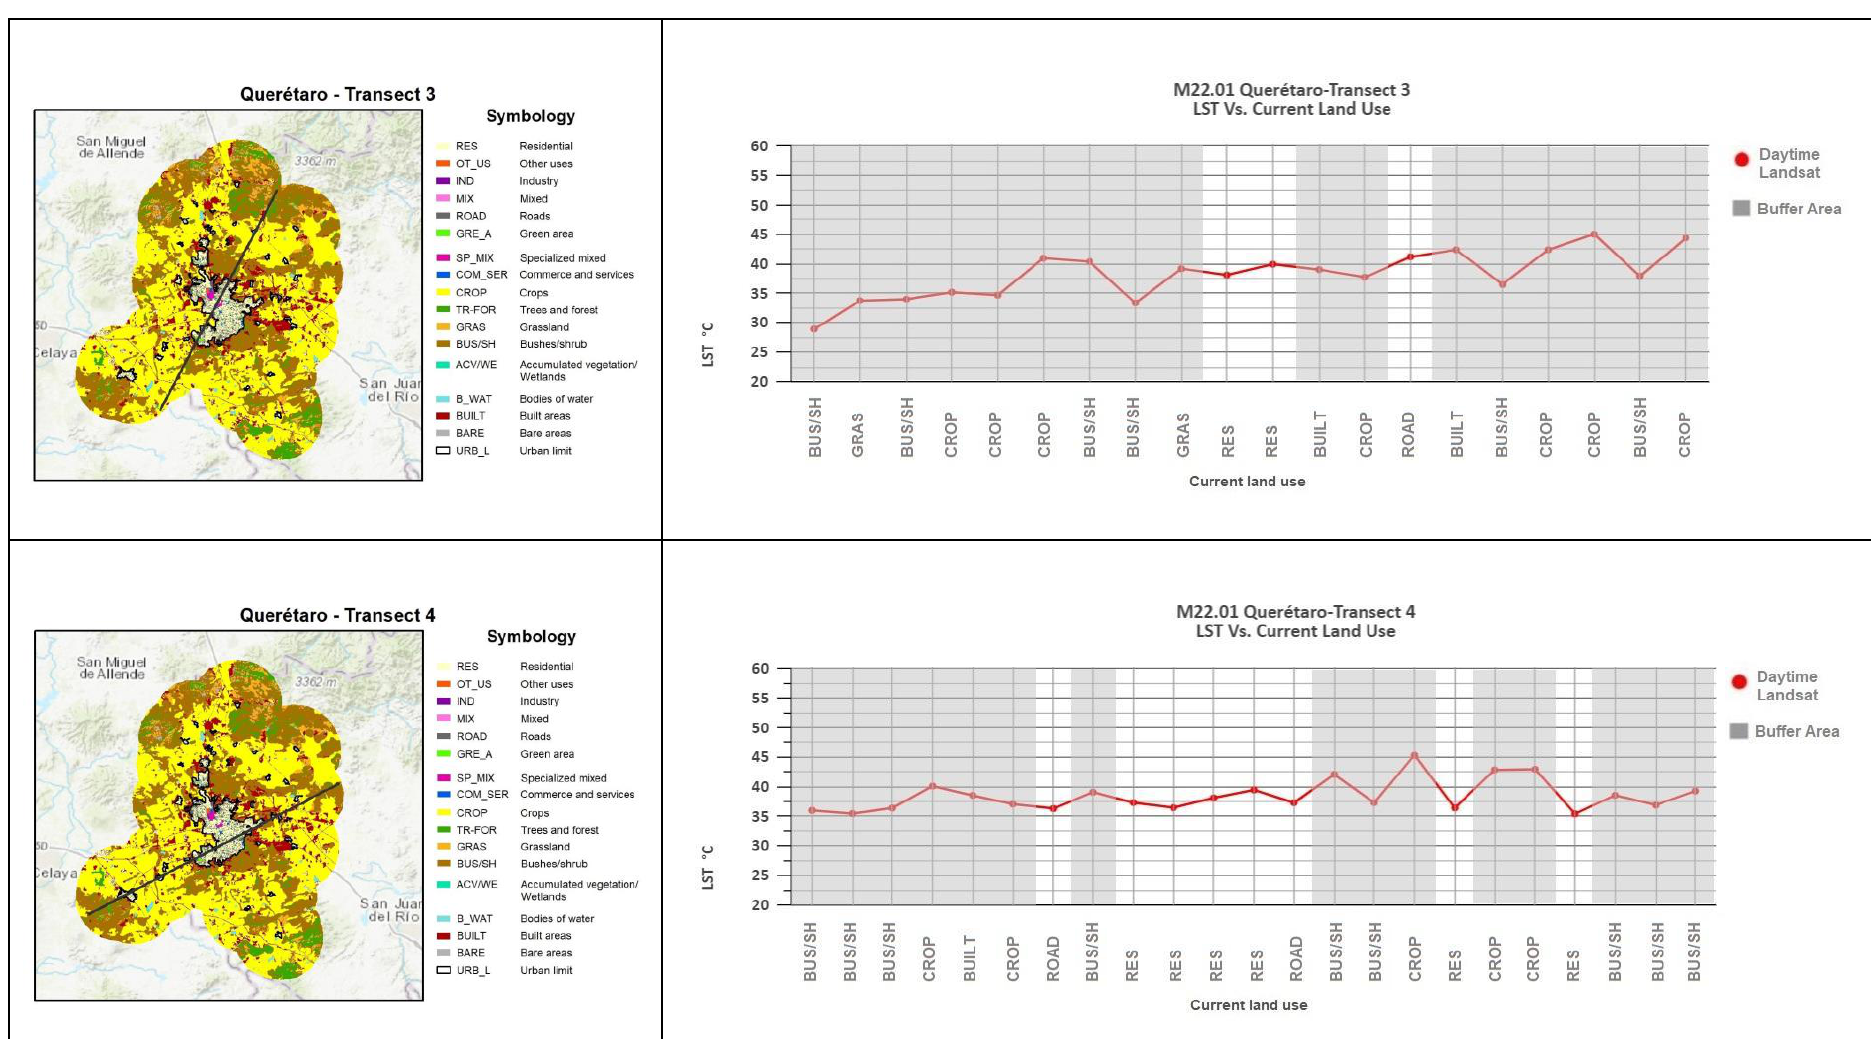
Figure 6. Transects of Querétaro metropolitan city.